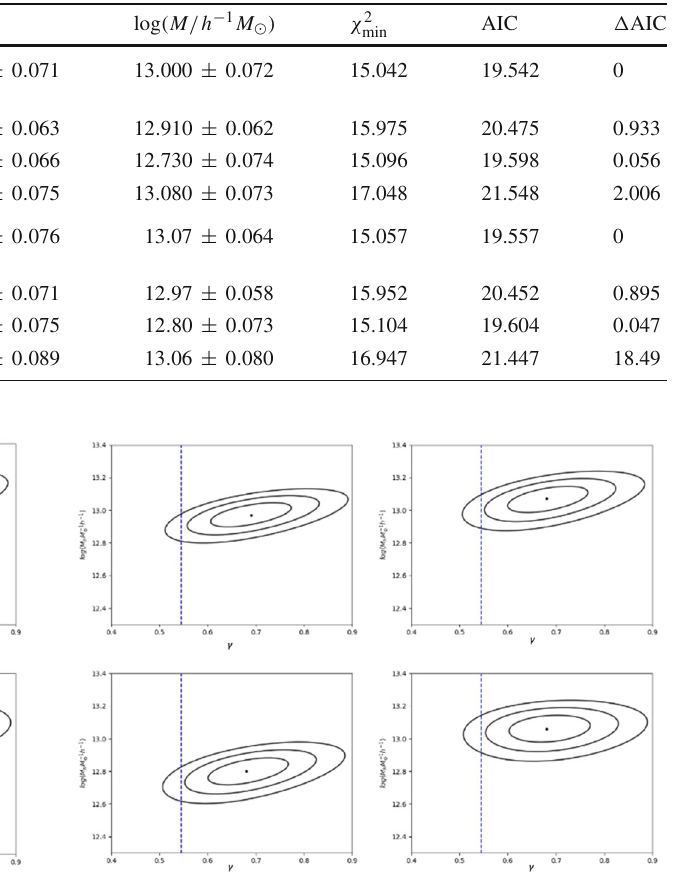
Table 2 Observational constraints for the joint analysis of bias (see Table 1) and growth rate data: The 1st column shows the expansion model (see Sect. 2; Abbott et al. [1]), the 2nd column indicates the bias models (see Sect. 3), the 3rd column corresponds to γ and the 4 rth